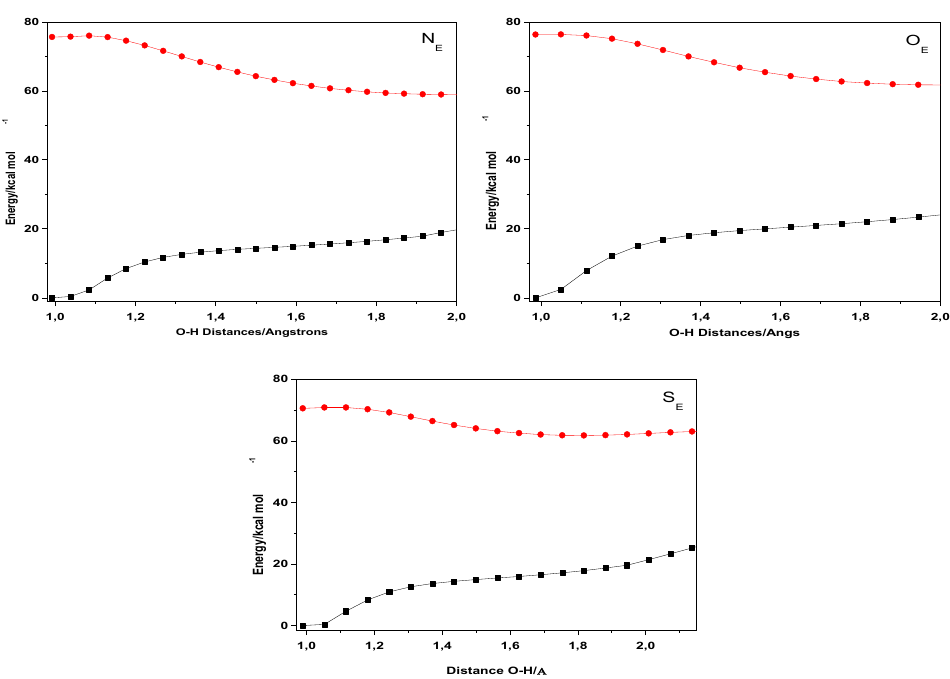
Figure 4. Calculated potential energy curves for the S 0 (in black) and S 1 (in red) states of N E , O E , and S E , respectively, along the proton transfer coordinate.